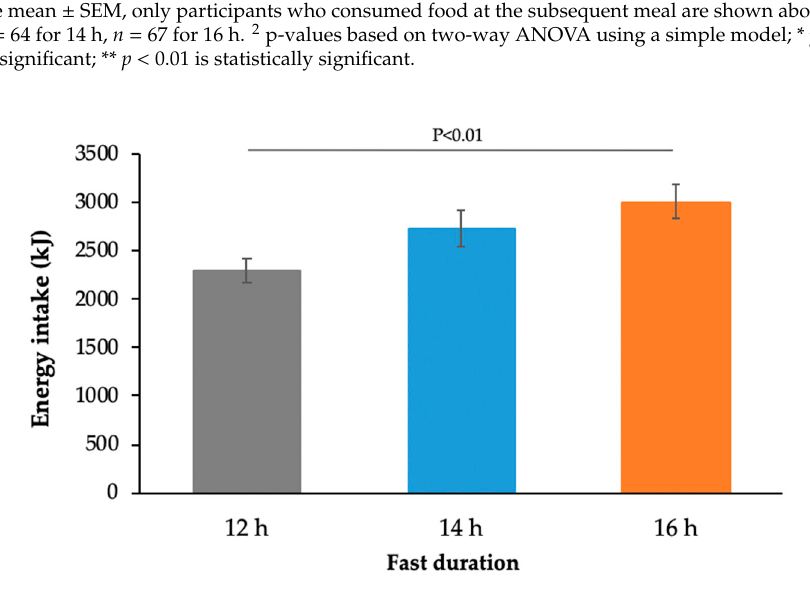
Figure 3. Energy intake at an ad libitum meal consumed 2 h after the standard breakfast meal (12 h: n = 59, 14 h: n = 64, 16 h: n = 67; p < 0.01, two-way